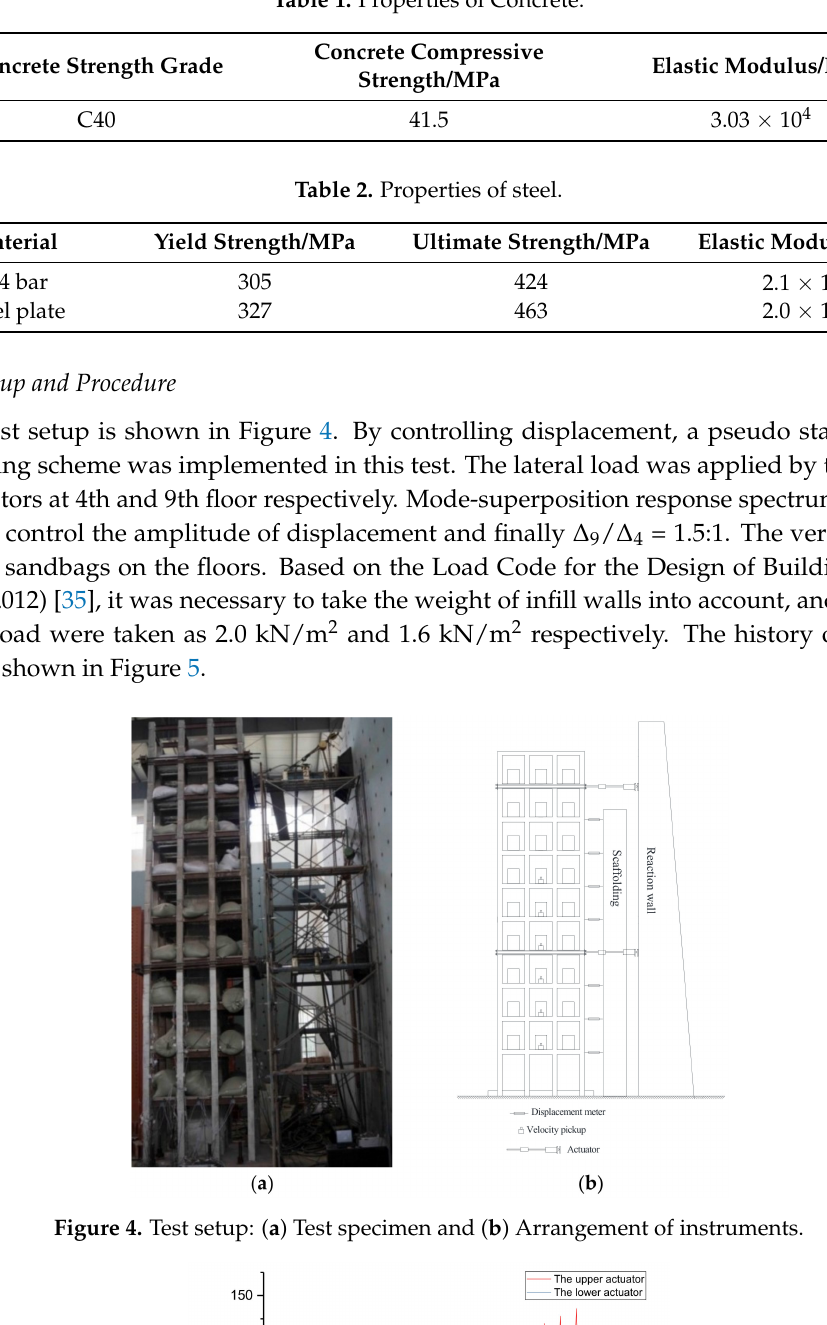
Table 1. Properties of Concrete.